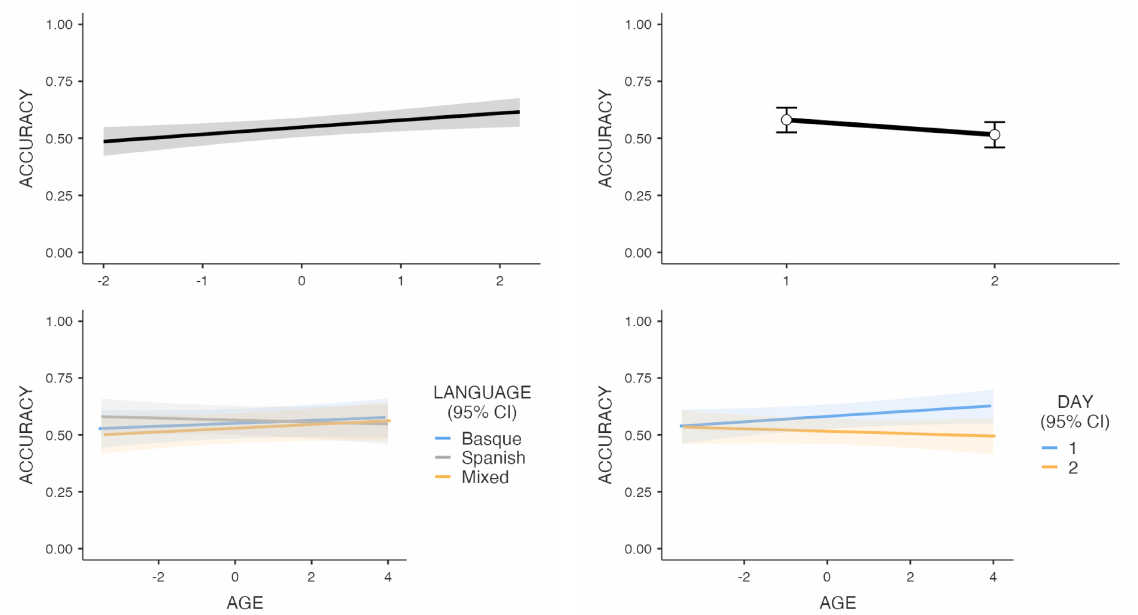
Figure 2. Graphical representation of the parameter estimates of the significant fixed effect Level of Basque ( upper left plot) and Day ( upper right ), and the Language*Age ( lower left ) and Day*Age ( lower right ) interactions.